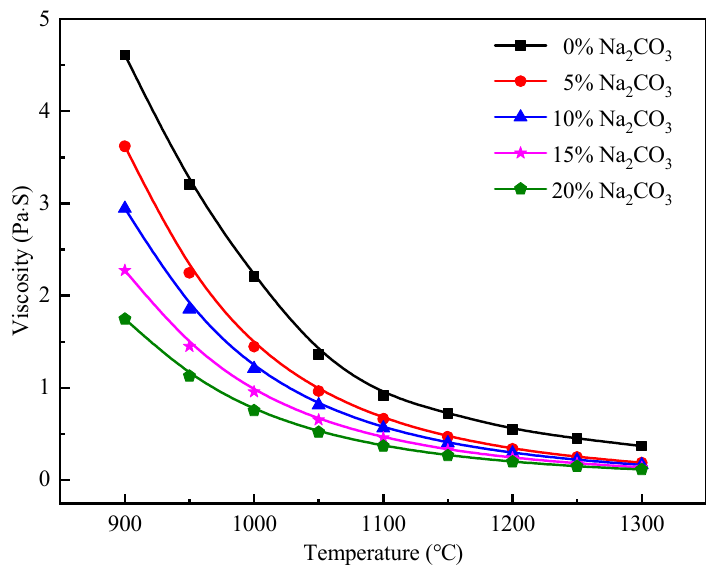
Figure 9. Relationship between the viscosity and the temperature of molten Cu slag containing different Na 2 CO 3 dosages. Minerals 2020 , 10 , x FOR PEER REVIEW